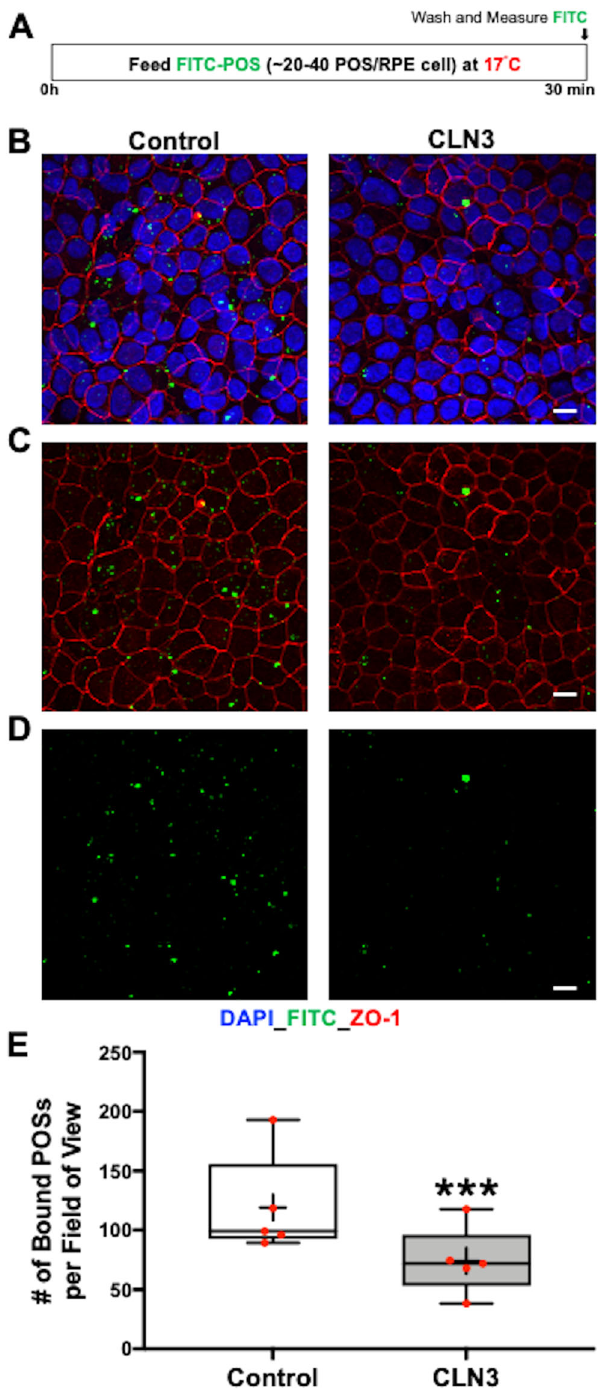
enlarged (Fig. 9H) and POS loss was observed in the area annulus (Fig. 9I). Altogether, longitudinal multimodal imaging on a CLN3 disease patient and previously documented ERG changes in CLN3 disease patients before the loss of vision 20,21 are concordant with POS phagocytosis defect causing photoreceptor cell loss and reduced RPE lipofuscin in CLN3 disease retina. This is critical for therapeutic intervention in CLN3 disease especially when taken in conjunction with our previous data (Fig. 8) showing rescue of POS phagocytosis defect by overexpression of WT CLN3 in CLN3 disease hiPSC-RPE cells.